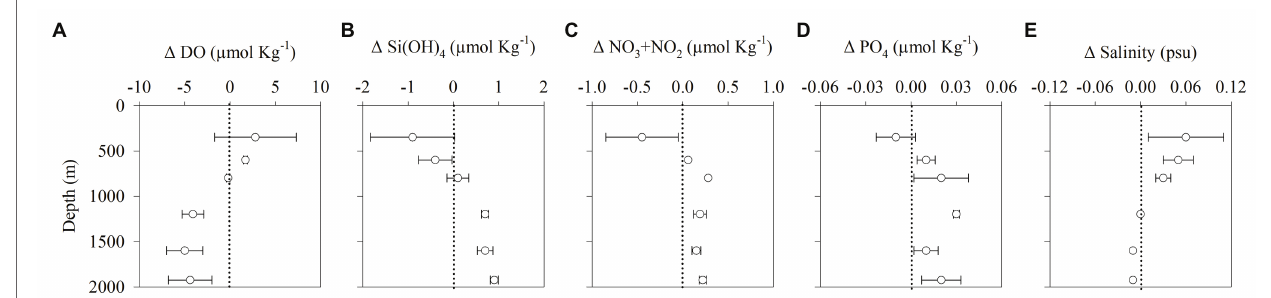
FIGURE 5 | The vertical net difference in (A) DO, (B) Si(OH) 4 , (C) NOx, (D) PO 4 , and (E) salinity at G05 between 2013 and